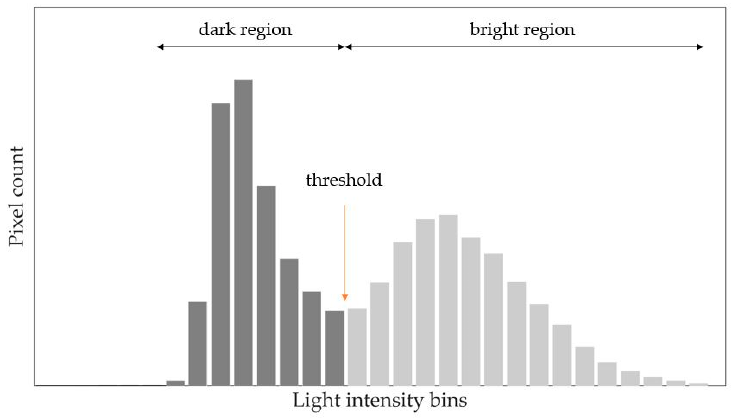
Figure 8. Light intensity histogram.